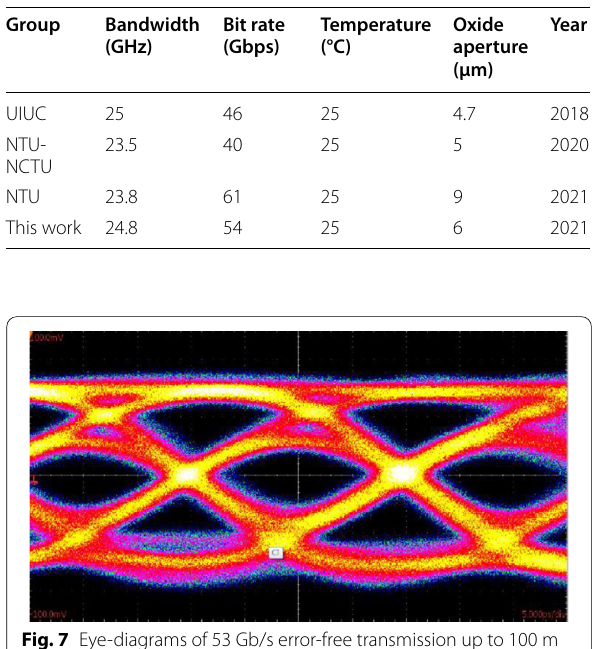
Table 1 Modulation bandwidths and bit rates of VCSELs at room temperature using the standard on–off keying in a back‑to‑back data transmission configuration [77–79]